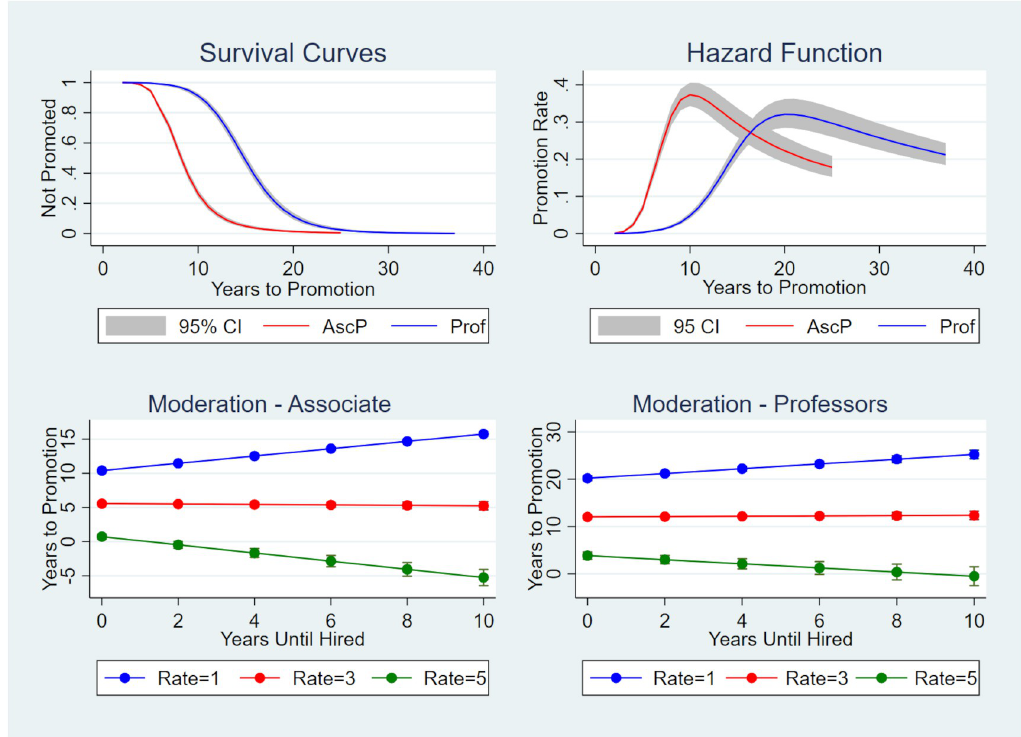
Fig 1. Graphs of hazard and survival curves and interaction. Upper two graphs are: (A) the survival curve of the proportion of professors not promoted vs. years to promotion, and (B) the hazard function showing rate of promotion vs. years to promotion. In both graphs red indicates associate professor (AscP) promotion, and blue full professor (Prof) promotion. The lower two curves show the interaction of years until promoted vs. years until hired as moderated by rate of publication where Rate is number of publications per year for associate professors (C) and full professors (D). Note that a publication rate of five is associated with a negative slope or faster promotion with increasing years until hired, and a publication rate of one is associated with a positive slope or slower promotion. In the upper graphs 95% CI is the 95% confidence level and in the lower graphs the 95% confidence intervals are shown by bars most obvious with Rate = 5 to the right.